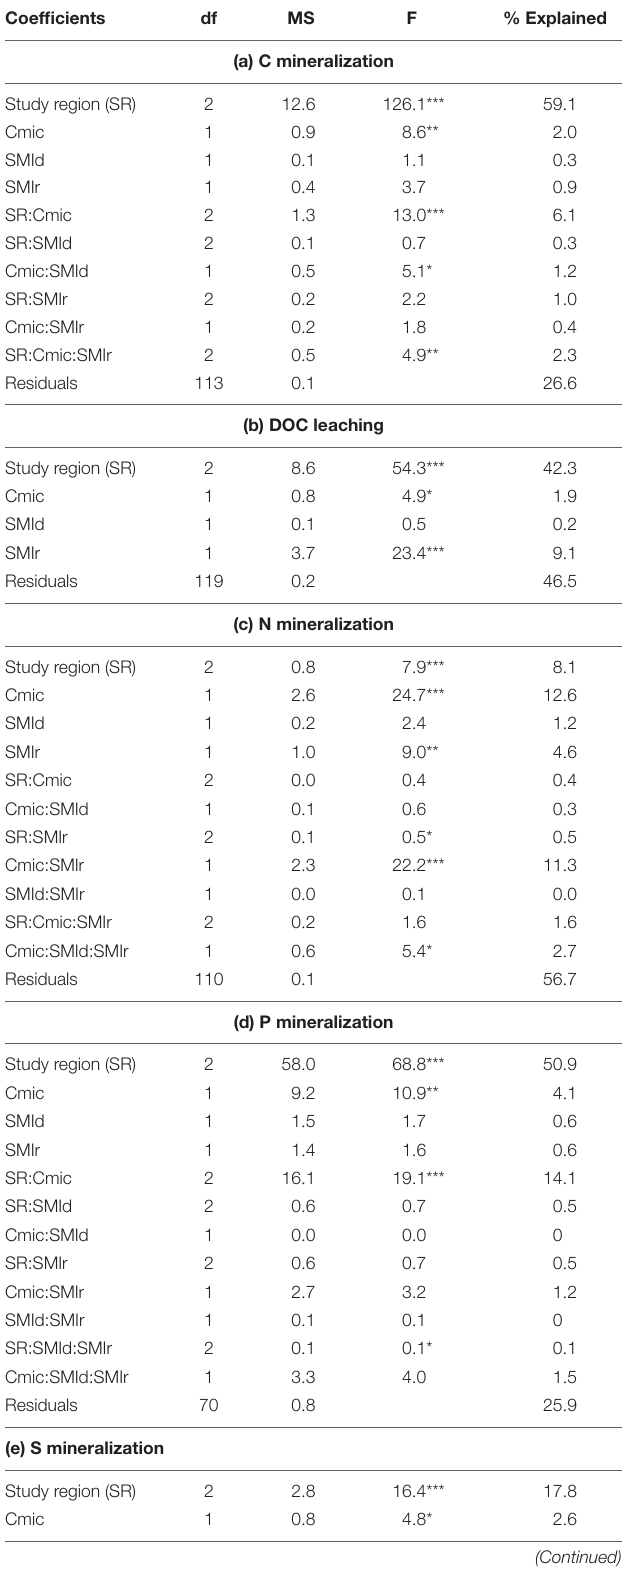
TABLE 3 | Results of the best predictive models on net soil mineralization rates (C, N, P and